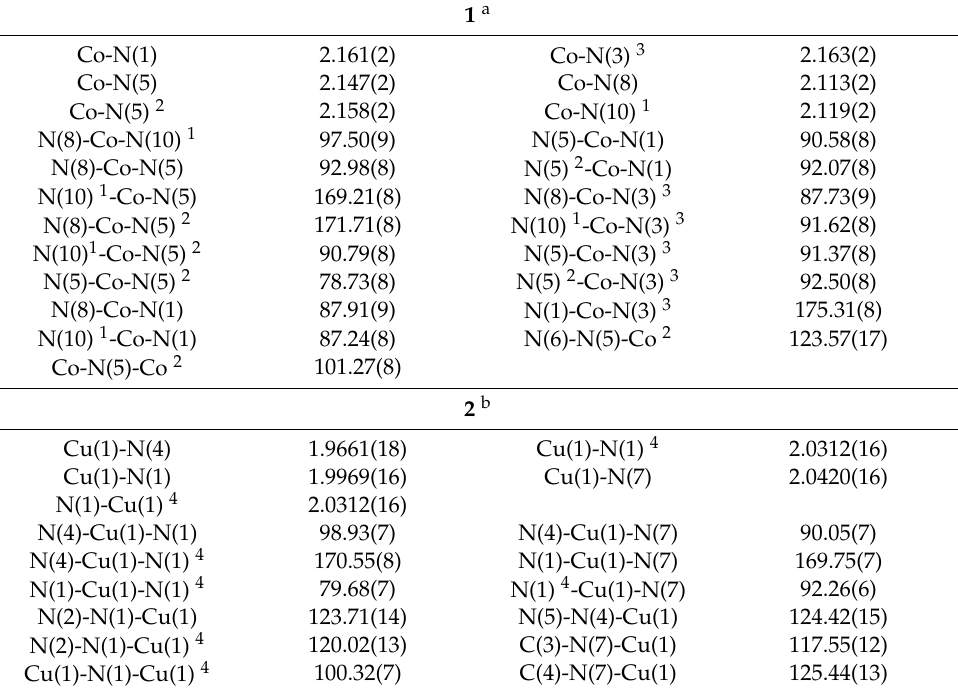
Table 2. Selected bond distances (Å) and angles ( ◦ ) for Compounds 1 and 2